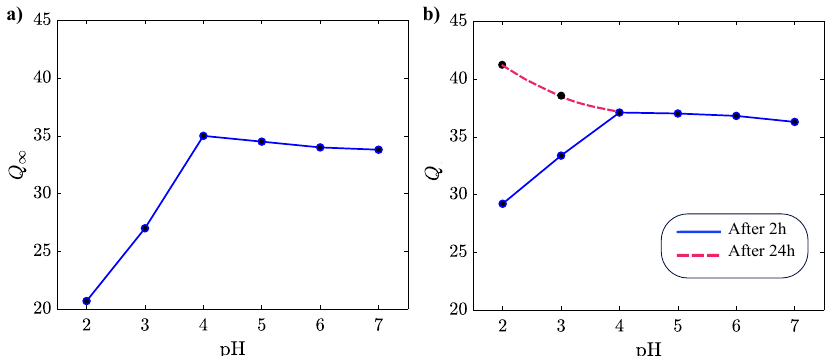
Figure 2. ( a ) Equilibrium degree of swelling Q ∞ versus pH for the alginate gel prepared by the conventional method. ( b ) Degree of swelling Q versus pH for the uniform alginate gel. Circles: experimental data, lines: guides for